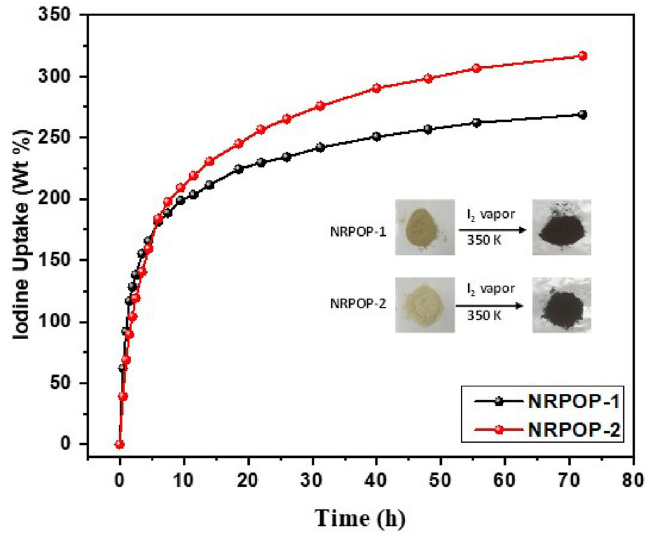
Figure 4. Gravimetric iodine uptake by NRPOPs overtime at 80 ℃ and ambient pressure; inset: photographs show the color change of NRPOPs after the exposure with iodine